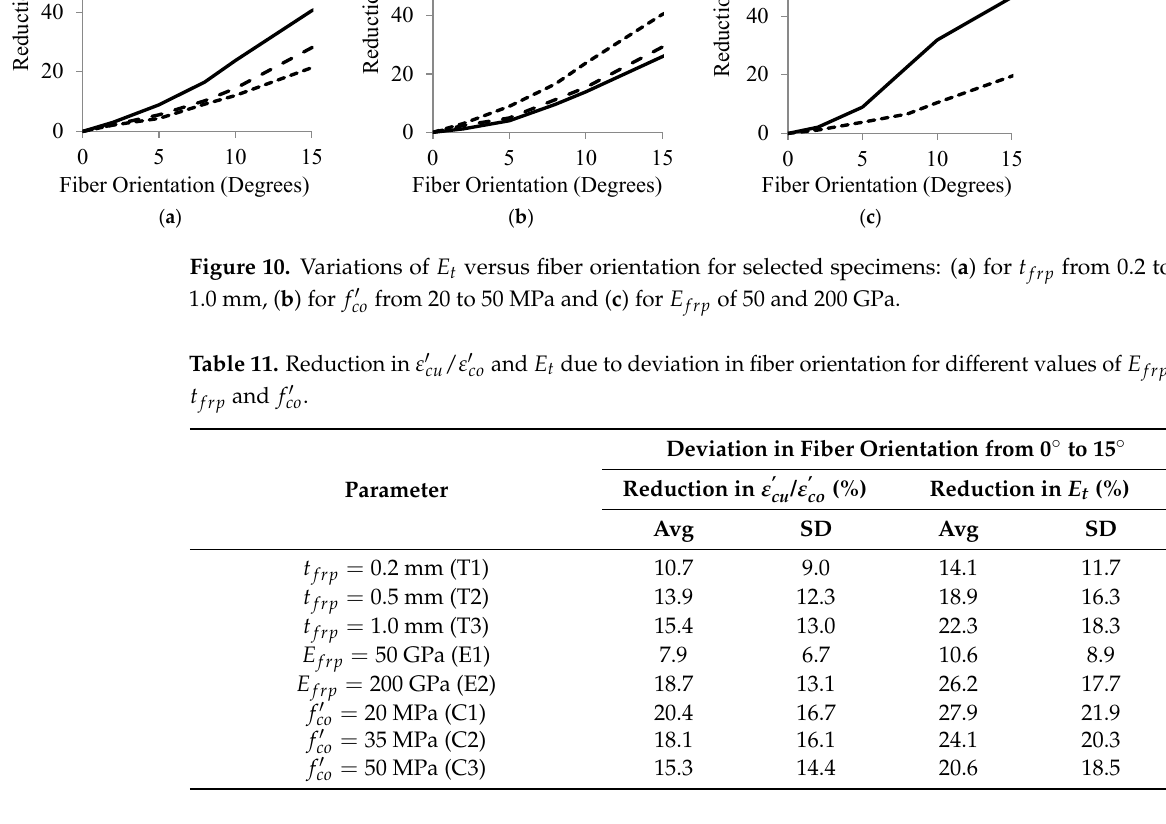
Table 12. Overall reduction in ε (cid:48) cu / ε (cid:48) co and E t for different fiber orientations. Fiber